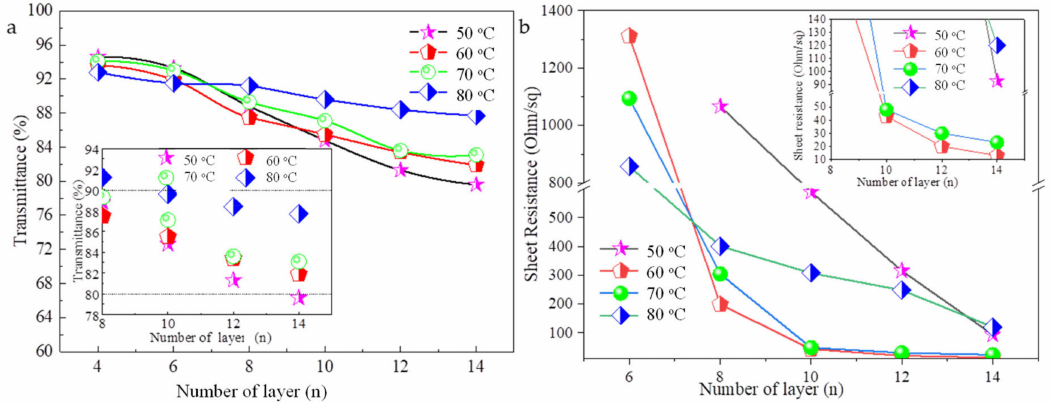
Figure 6. Transmittance at 550 nm ( a ) and sheet resistance ( b ) of the AgNWs films with different printed layers under different heat treatment temperatures. The inserts are local